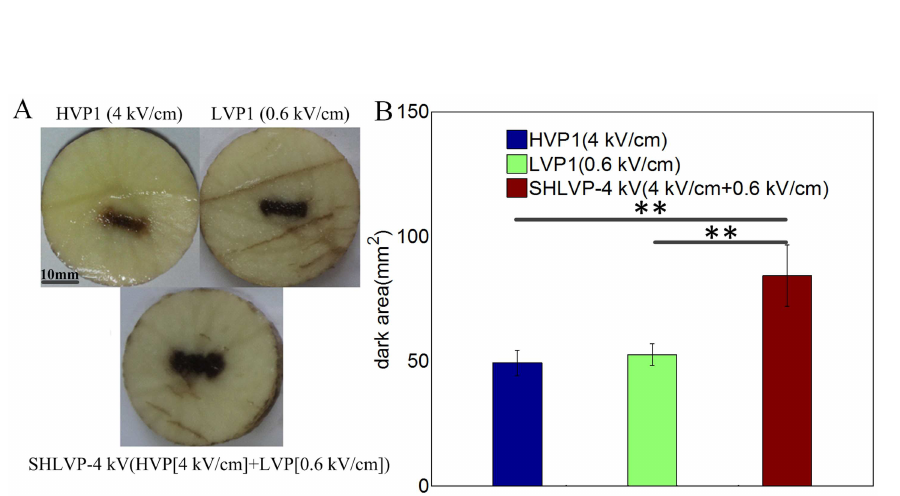
Fig 6. Increased electric field strength of the LVP component of SHLVPs augments the ablation area. The parameters were as follows: LVP2: 0.4–1 kV/cm, 100 μ s, 60 pulses; SHLVP-4 kV, including HVPs (4 kV/ cm, 2 μ s, 20 pulses) and LVPs (0.4–1 kV/cm, 100 μ s, 60 pulses). Data are shown as the average ± SD; ( *** , p < 0.001).Detailedprotocol parameters are shown in Table 4.